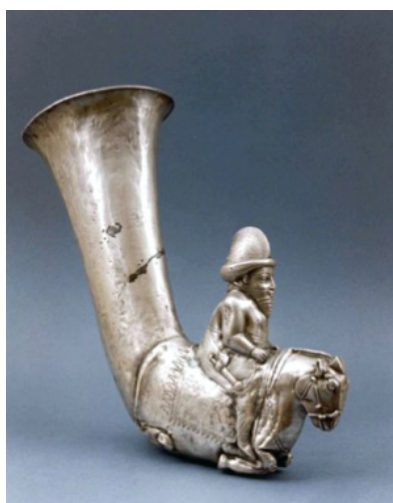
Figure 8. Drinking vessel in shape of horse with rider (EHAM inv. no. 20); rhyton, silver; Erebuni, Armenia; (post?) Achaemenid, ca. 4th cent. BCE [image courtesy of the Erebuni Historical and Archaeological Museum-Reserve, Yerevan].